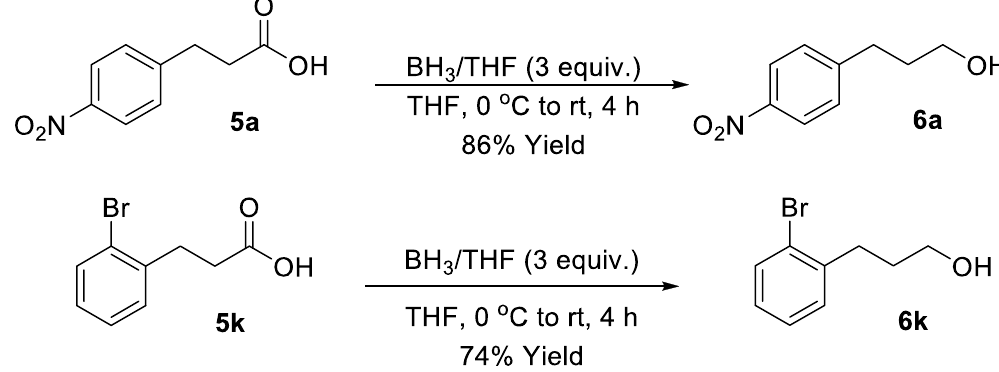
Figure 7. Borane reduction of 4-nitro 5b and 2-bromo 5k derivatives.